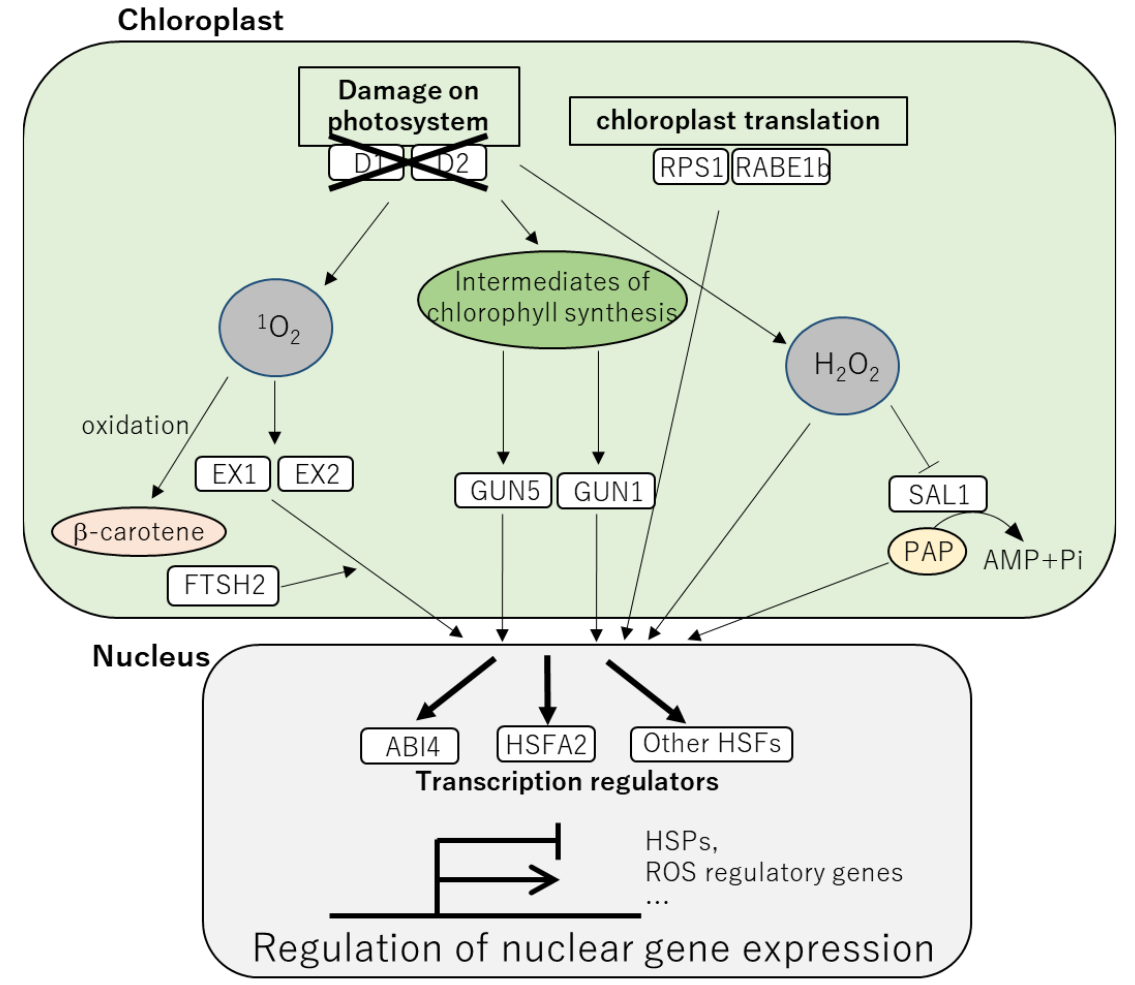
Figure 1. Retrograde signaling from the chloroplast associated with heat response in plants. ROS ( 1 O 2 and H 2 O 2 ) and the intermediates of chlorophyll synthesis function as key regulators of retro- grade signaling that activates or inhibits several proteins. These proteins activated via ROS or the chlorophyll intermediates transfer the signals from the chloroplasts to the nuclei, leading to activation or inhibition of nuclear gene expression.